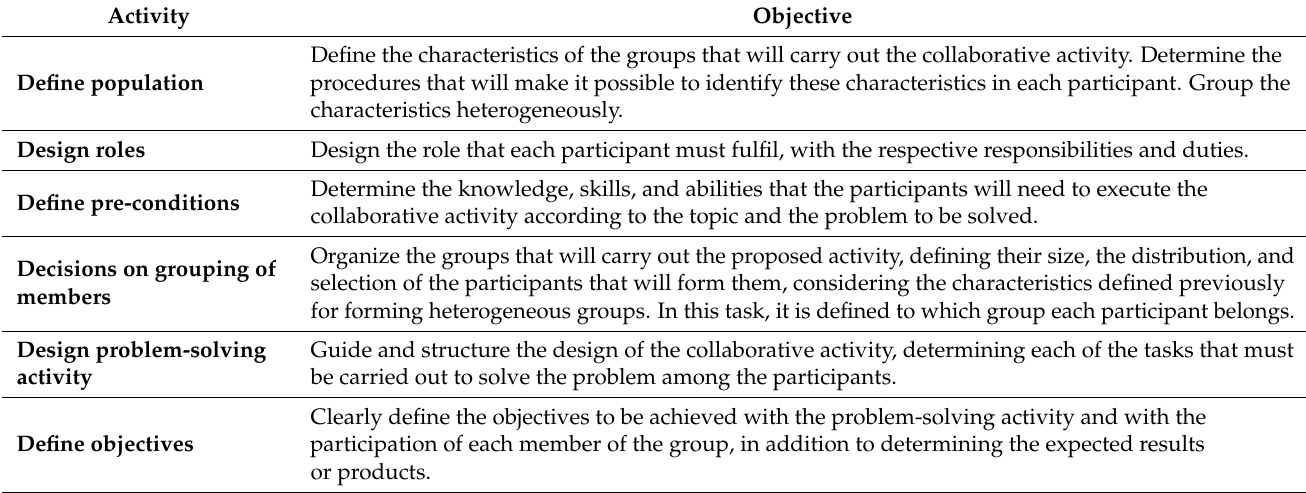
Table 1. Objective of each of the pre-process activities .